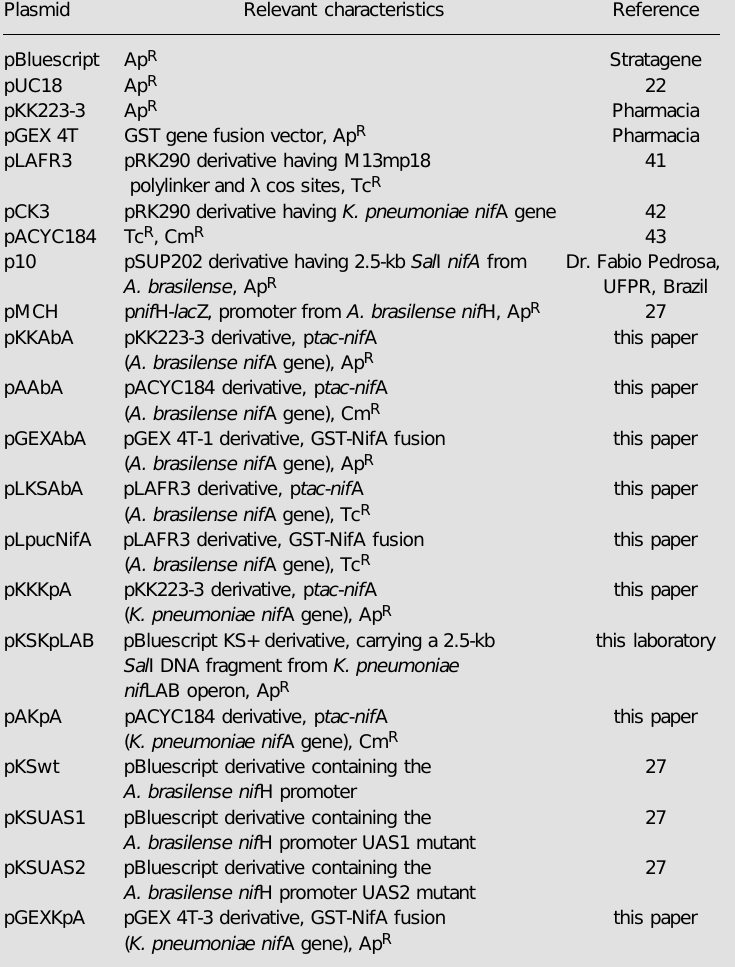
Table 2 - Plasmids used in the present